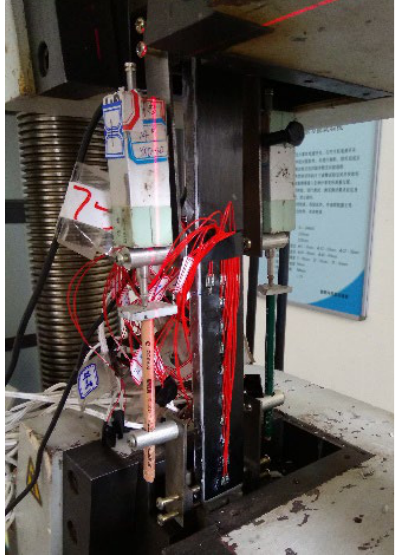
Figure 3. Test setup and instrumentation for the double-lap joint tensile tests. Four kinds of failure modes, which included steel/adhesive interfacial debonding, cohesive failure, CFRP/adhesive interfacial debonding, and CFRP delamination, were observed in the experimental study. Test results showed that the failure mode of the bonding interface mainly depended on the adhesive thickness rather than the corrosion duration;. Moreover, corrosion was found to have a positive effect on the ultimate load for the double-lap joints with the same failure mode of steel/adhesive interfacial failure, and the effective bond length of the corroded specimens were obviously larger than that of the un-corroded ones. Results also indicated that, for the specimens with the same corrosion duration, the failure modes changed from the combination of steel/adhesive interfacial failure and CFRP/adhesive interfacial failure to the combination of CFRP/adhesive interfacial failure and CFRP delamination (see Figure 4); the ultimate load increased at first and decreased afterwards, and the effective bond length progressively increased with the adhesive thickness from 0.5 to 1.0, 1.5, and 2.0 mm.